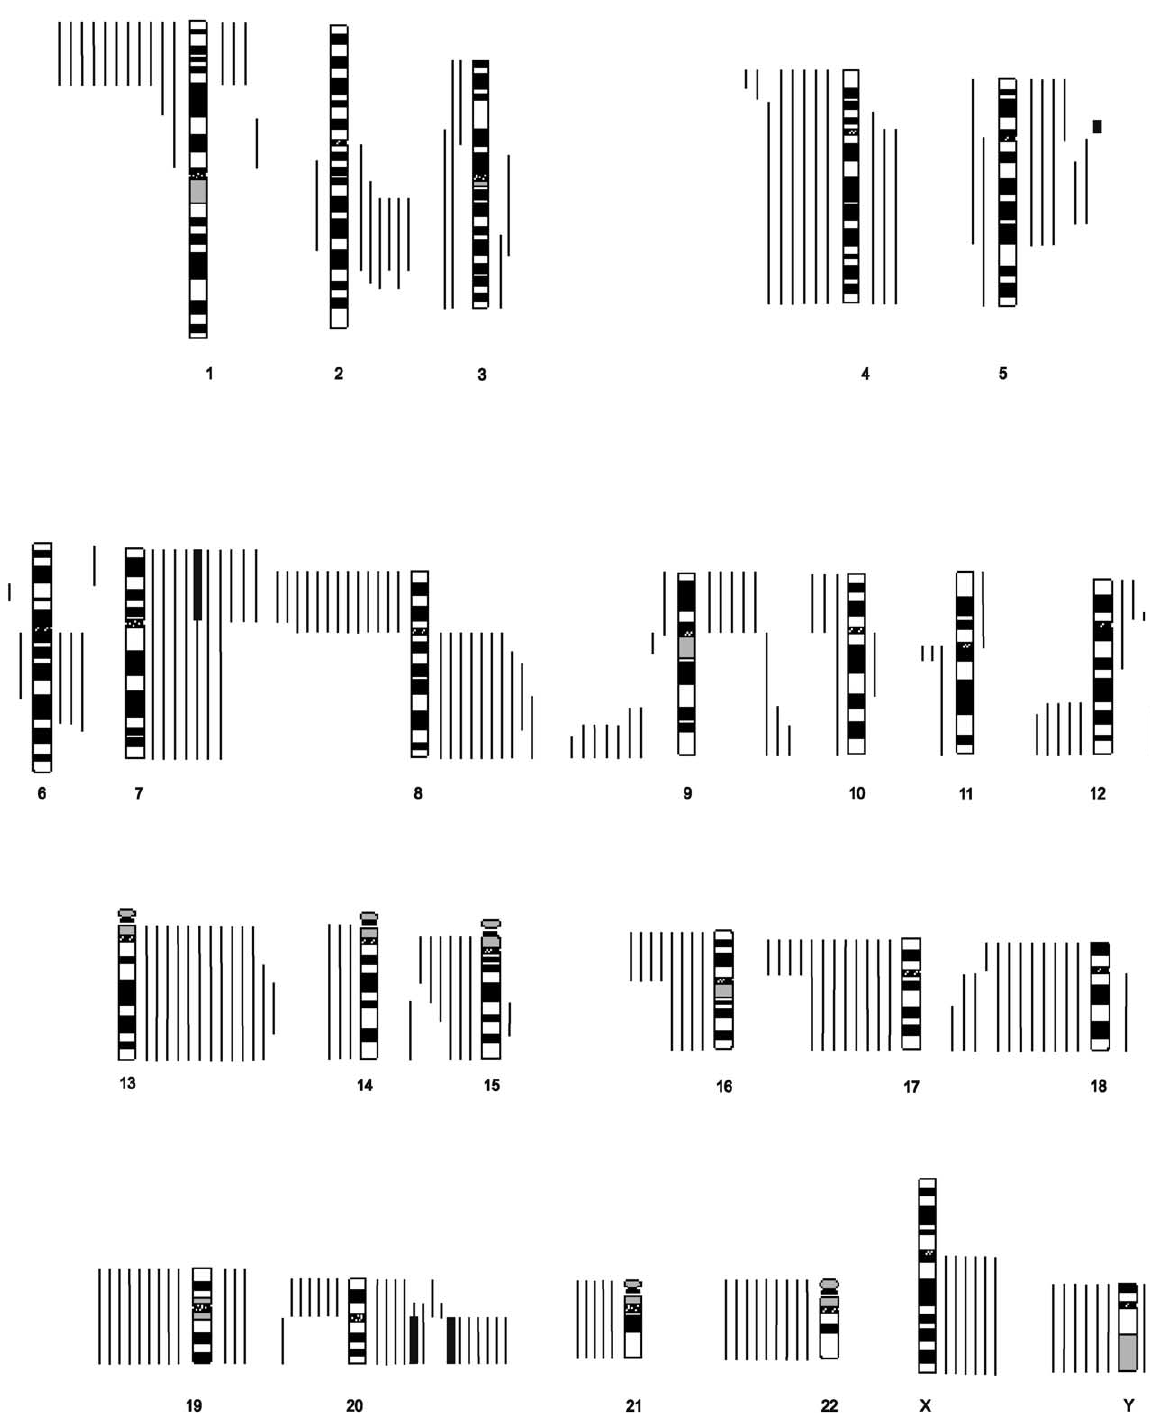
Fig. 2. Karyogram of chromosomal gains and losses in 18 colorectal carcinomas with synchronous liver metastases (group